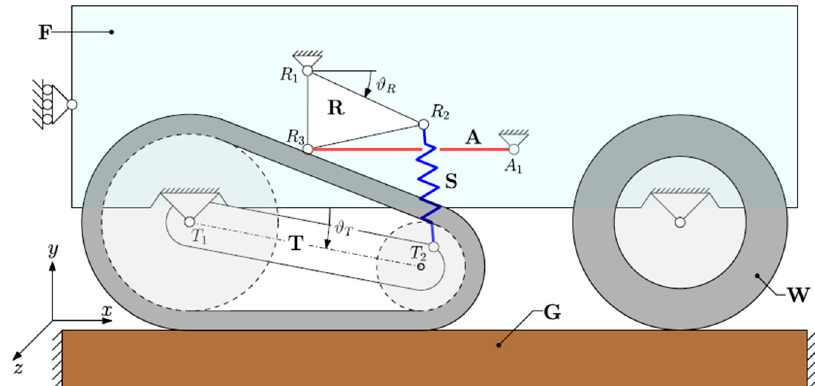
Figure 2. Scheme of the main components of the model.